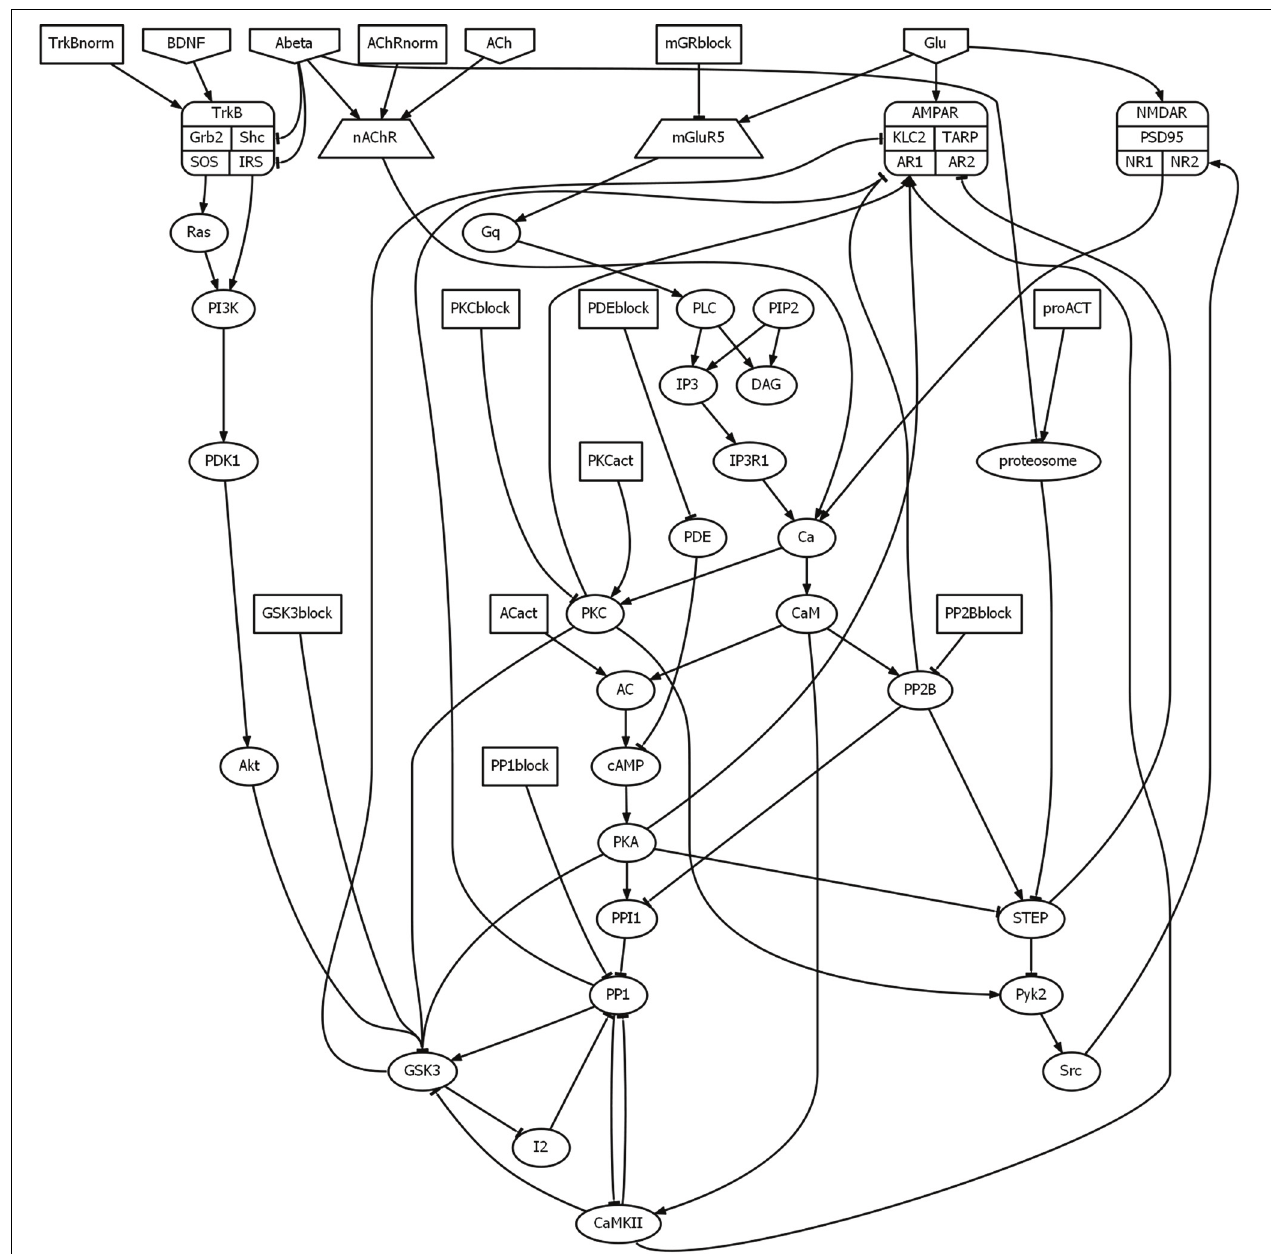
FIGURE 1 | Schematic of the data-driven model of the effects of A β on synaptic plasticity. The diagram depicts the influences that each element has on the other elements in the model. Arrowheads and tees